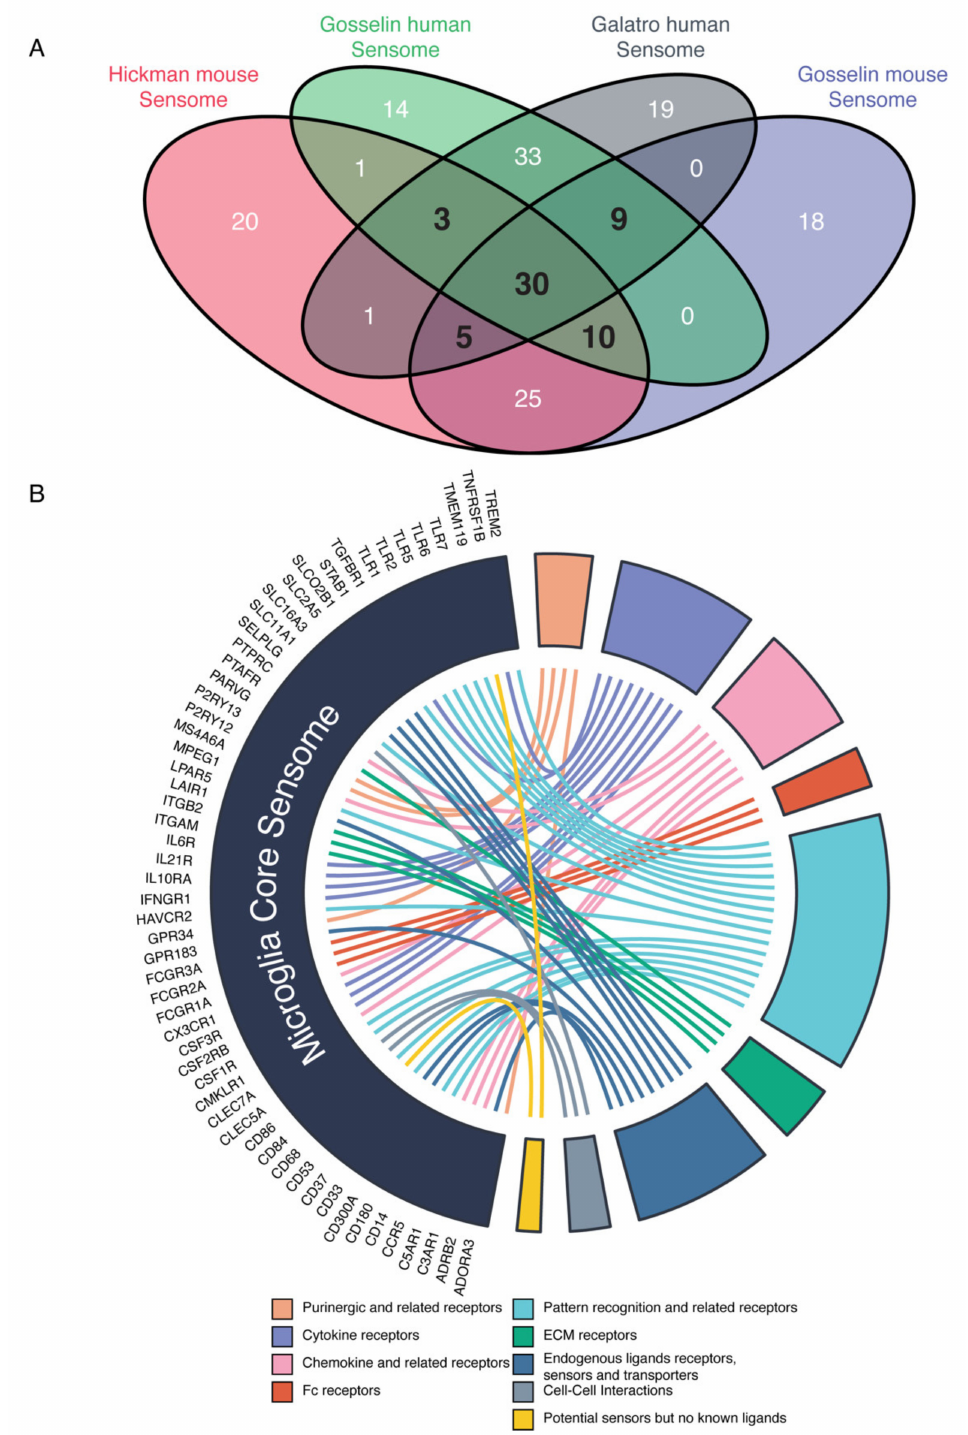
Figure 3. Overlap between mouse and human sensome reveals microglia core sensome. ( A ) Overlap between human and mouse sensome genes. We defined the microglia core sensome as genes present in three out of four sensome datasets (in bold). ( B ) Circ plot illustrating the functional subgroups of the microglia core sensome genes as identified by the shared expressed sensing genes in human and mouse